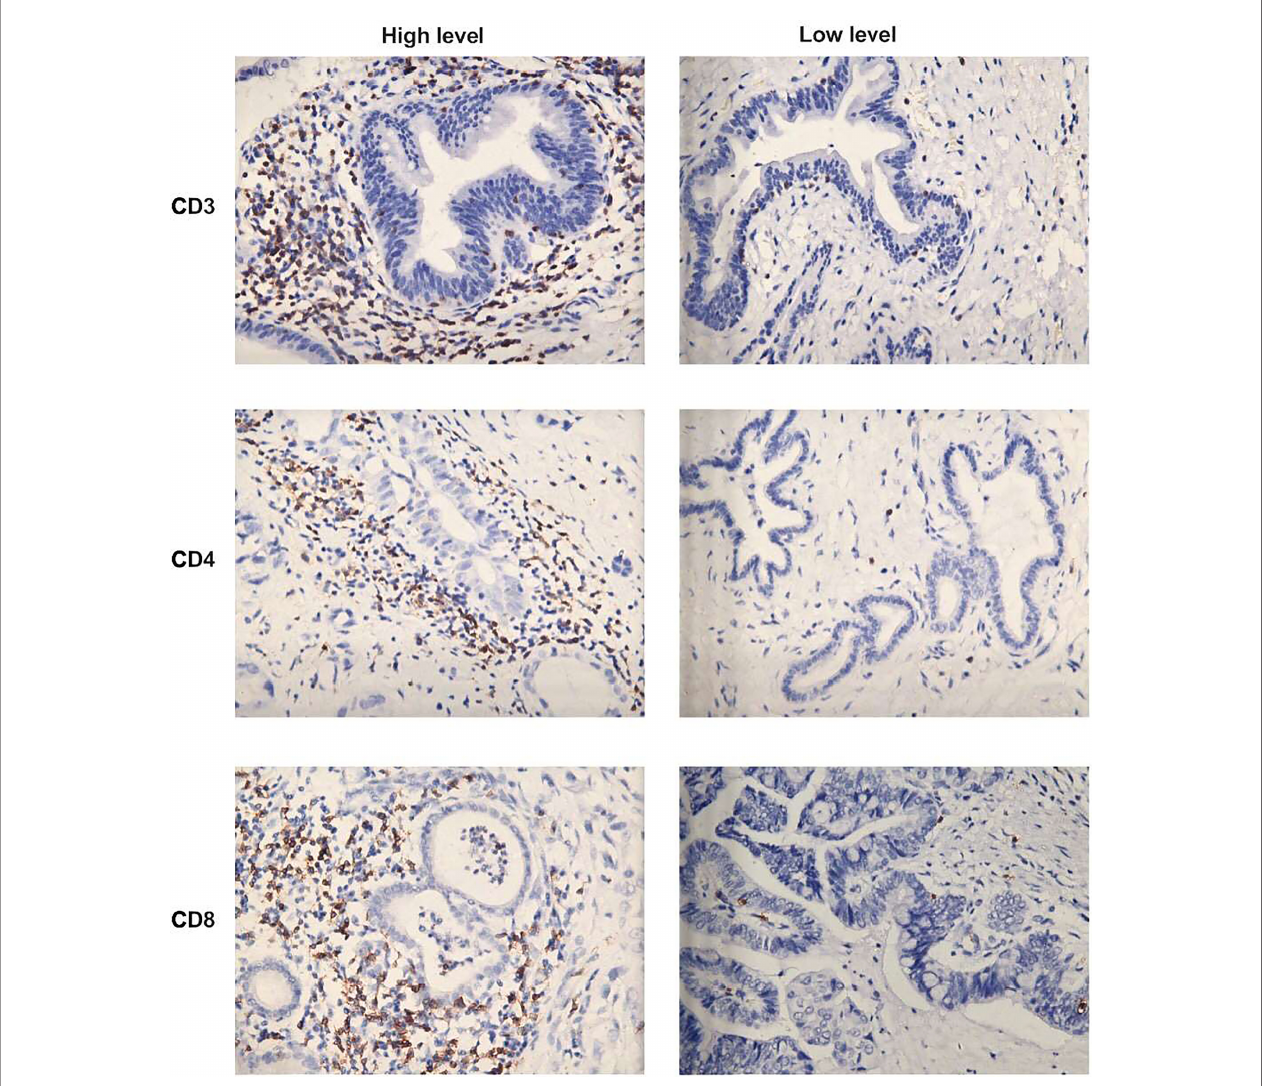
FIGURE 1 | Representative images of immunohistochemical features of high-level and low-level tumor-in fi ltrating in fl ammatory cells in hilar cholangiocarcinoma: CD3 + T cells, CD4 + T cells and CD8 + T cells. (×400 magni fi